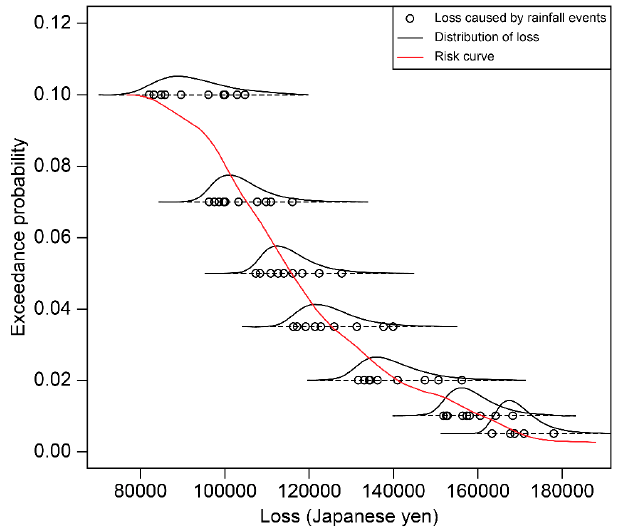
Figure 10. Risk curve in terms of economic loss. (The exchange rate between U.S. dollar and Japanese yen is about 1:111.).